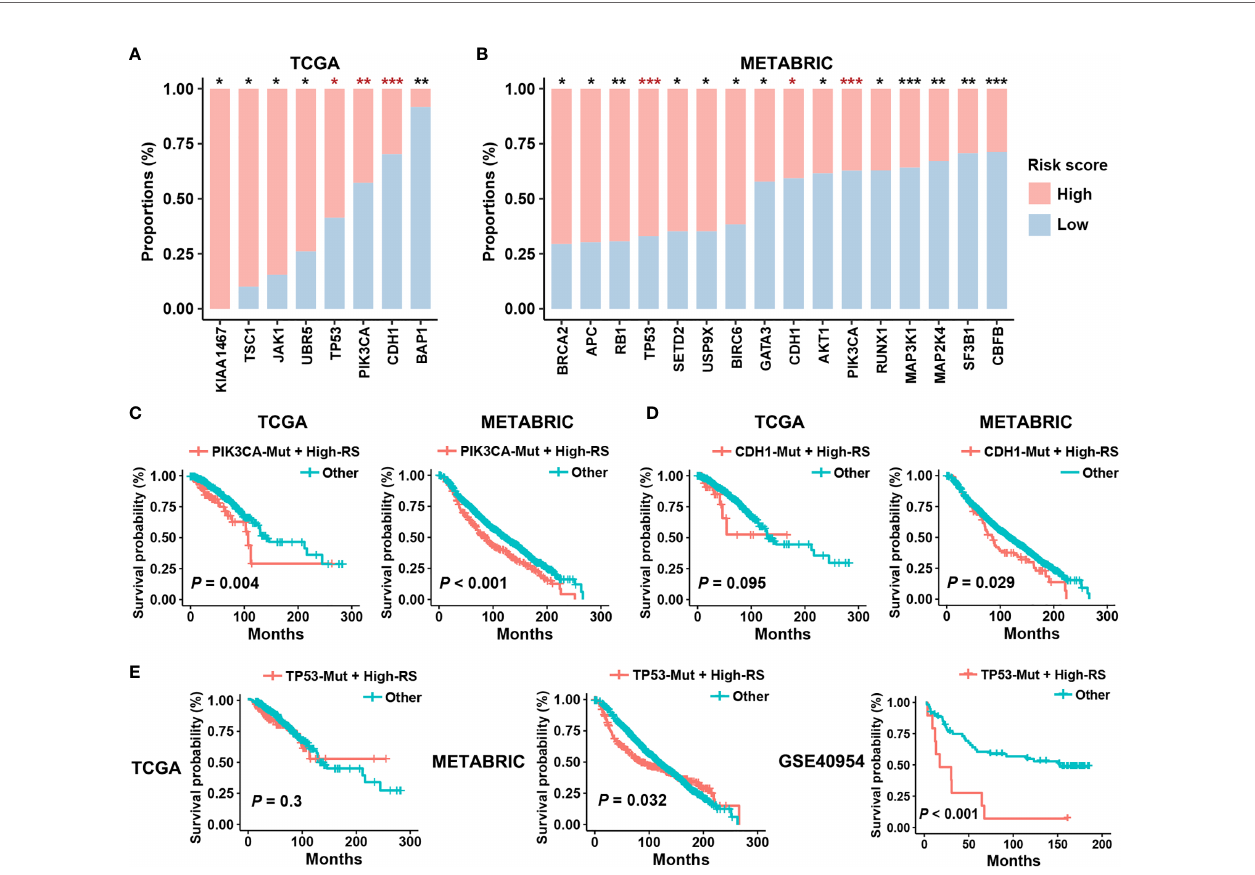
FIGURE 5 | Prognostic risk of high-RS patients harboring driver mutations. (A, B) Non-synonymous mutations of driver genes (Cancer Gene Census, v84) within high- or low-RS groups in TCGA and METABRIC cohorts. The consistent trends were observed among TP53, PIK3CA, and CDH1 mutations. P value indicated by Fisher ’ s exact test. *** P < 0.001; ** P < 0.01; * P < 0.05. (C) High-RS patients harboring PIK3CA mutations had signi fi cant poor prognosis in both TCGA and METABRIC cohort. (D, E) High-RS level contributed more prognostic risk to CDH1 or TP53 mutated cases in the METABRIC dataset, and GSE40954 validated the higher risk of high-RS cases harboring TP53 mutations. P value suggested by log-rank